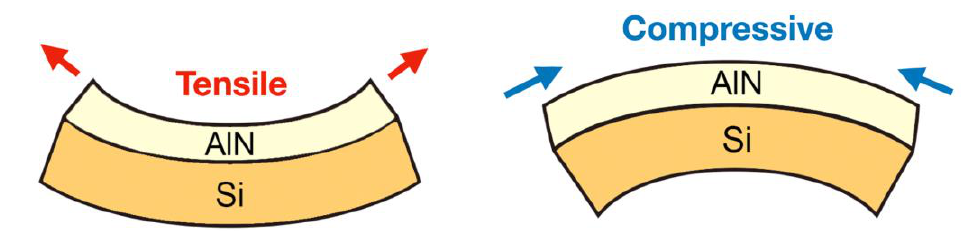
Figure 5. Diagram showing tensile and compressive force acting on the sample during the process.